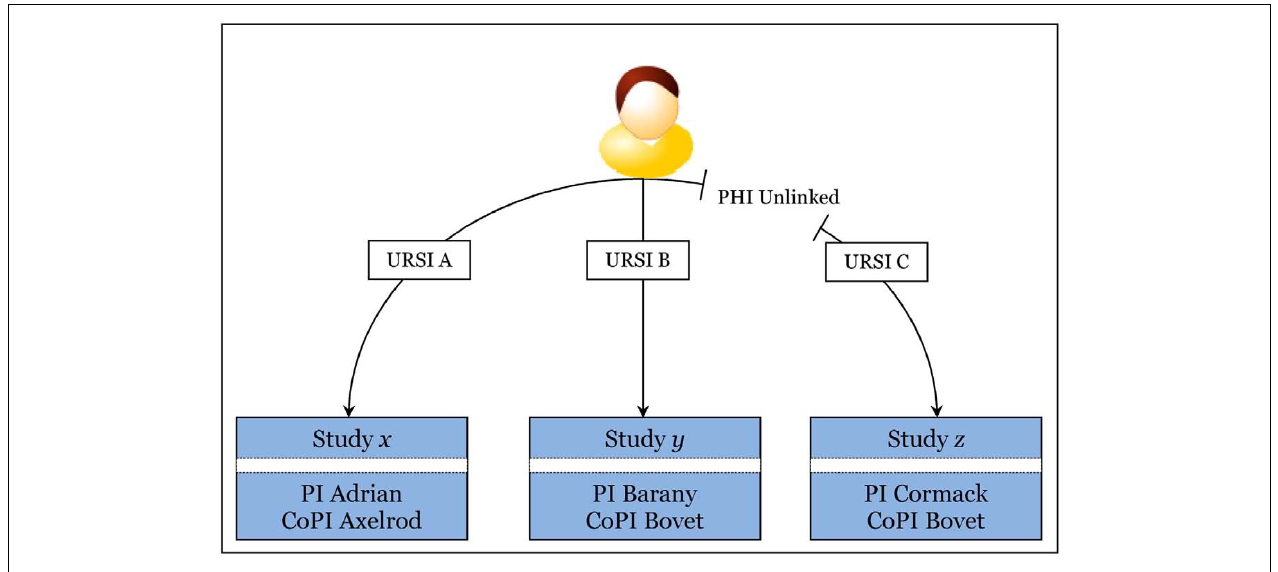
some document linking URSI C to URSI B since he has privilege in both studies and URSI B is still linked. Compare to PI Adrian and CoPI Axelrod in the lower left box: they are blinded to the other studies y and z, regardless of linking. Summarily, if the user is in at least two of the studies the subject is in, there is a potential exposure, and this is outside of the technology